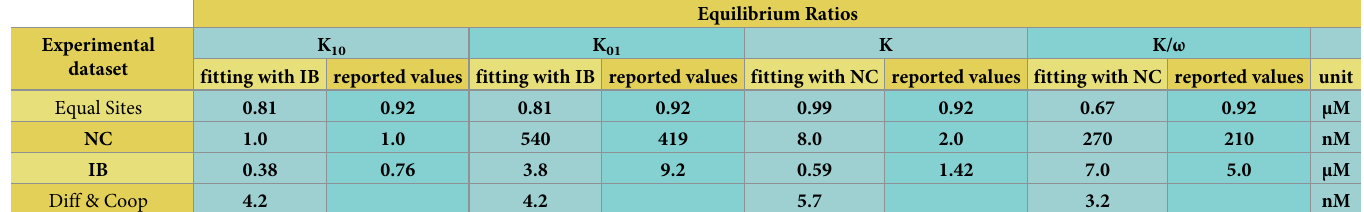
Table 1. Equilibrium ratios for the experimental databases. For each of the four experimental databases considered (listed on the first column: Equal Sites, NC , IB , Diff & Coop) the equilibrium dose-response curve was fitted both with the mathematical expression corresponding to an IB description and with that of an NC description (Eqs (1) and (2) in the main text), obtaining K 10 and K 01 , or K and K/ ω , respectively. For the experimental databases labeled Equal Sites, NC and IB both fittings are good, because of the indistinguishability reasons. The considered articles fitted the data (dose-response curve in equilibrium) using a two-site model ( TS ); this model is described in detail in the S1 Text. The TS model provides two parameters, K 1 and K 2 . By comparing the equilibrium dose-response curves from IB and NC models, with that of the TS model, a mathematical relationship between K 1 -K 2 and K 10 -K 01 , and K 1 -K 2 and K-K/ ω was obtained. Summarizing, the papers provide K 1 -K 2 , and using the mentioned relationships the inferred K 10 -K 01 and K-K/ ω are calculated from those reported values, to be compared with the inferred K 10 -K 01 and K-K/ ω from fitting with IB and NC models. Data coming from Diff and Coop does not have reported K 1 nd K 2 , that is why that row is